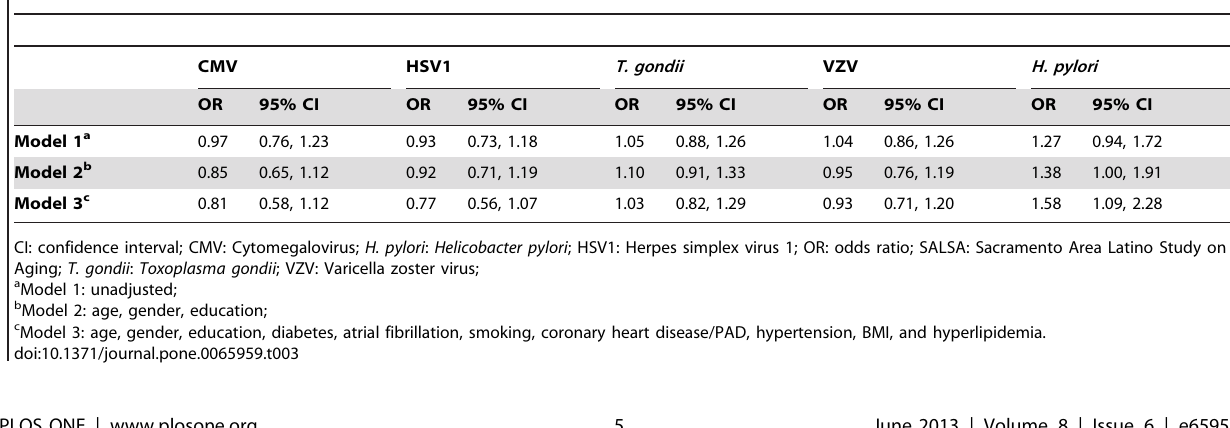
Table 3. IgG Antibody Levels to Persistent Pathogens (Comparing 75 th and 25 th Percentiles) and Incident Stroke, SALSA, California,